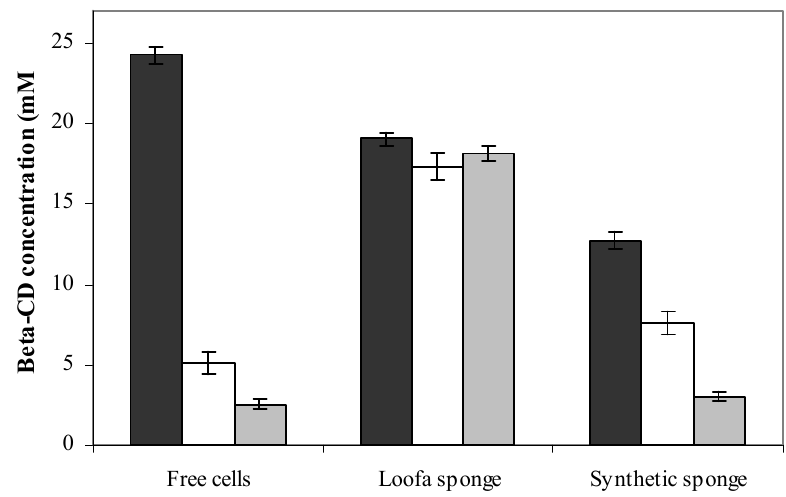
Figure 4. Effect of immobilization time on β -CD production by free and immobilized cells. ( ) 10 days; ( ) 20 days; and ( ) 30